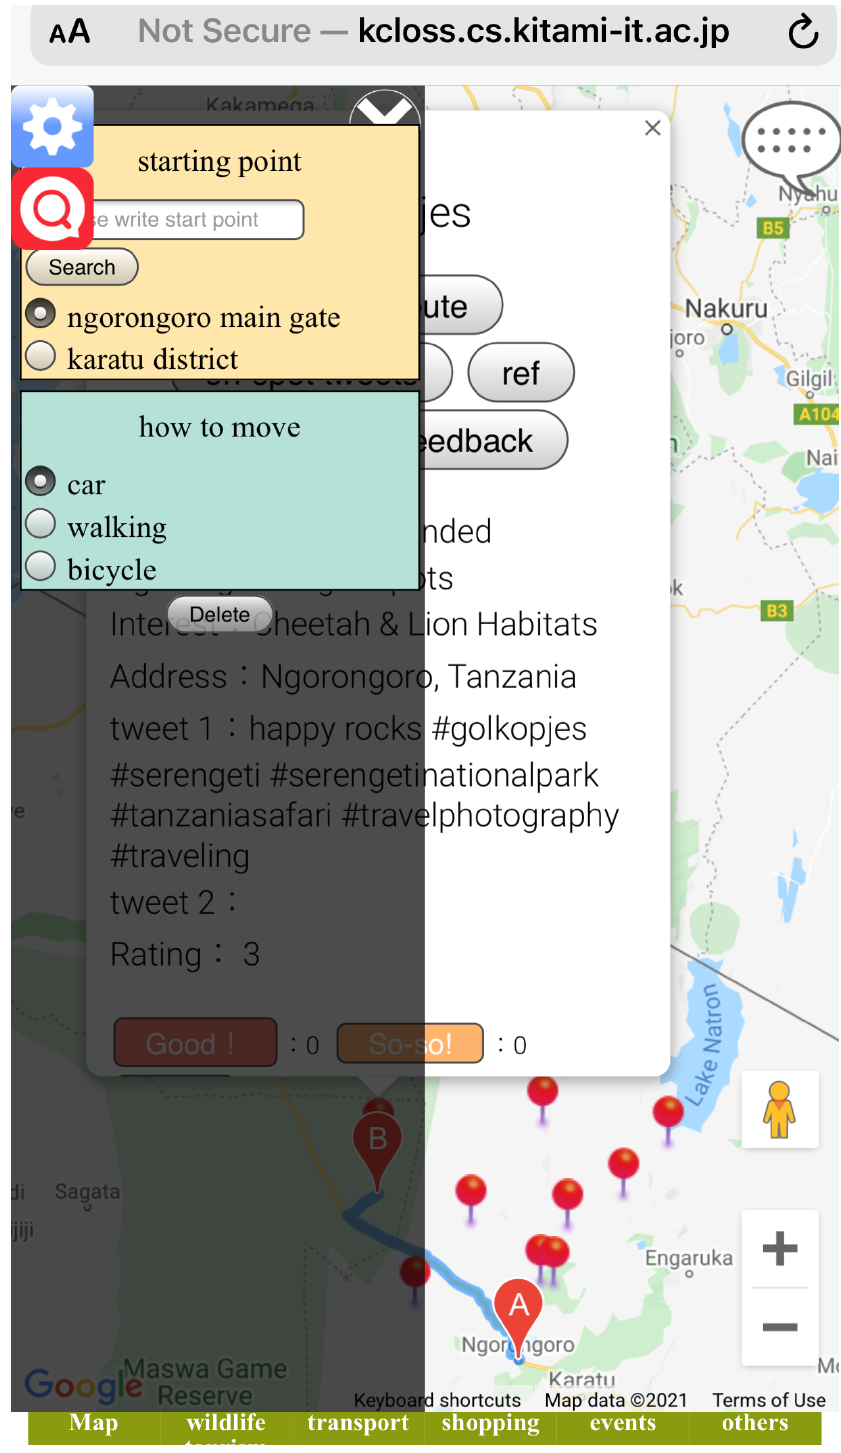
Figure 12. Route search